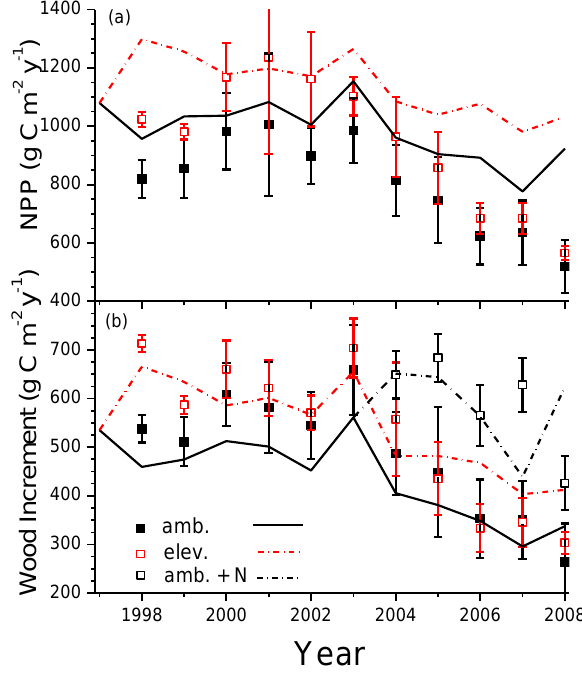
Fig. 5. (a) Annual net primary productivity (NPP) and (b) Fig. 5 gain in biomass measured (symbols) and modelled (lines) from 1998 to 2008 under ambient ( ∼ 370µmolmol − 1 ) vs. elevated ( ∼ 550µmolmol − 1 ) C a with or without N fertilizer at the ORNL FACE experiment. Measured data from Norby et al. (2010), with er- ror bars representing standard errors from replicated measurements ( n = 2). Root exudation (Grant, 1993) was excluded from modelled NPP to simulate biometric